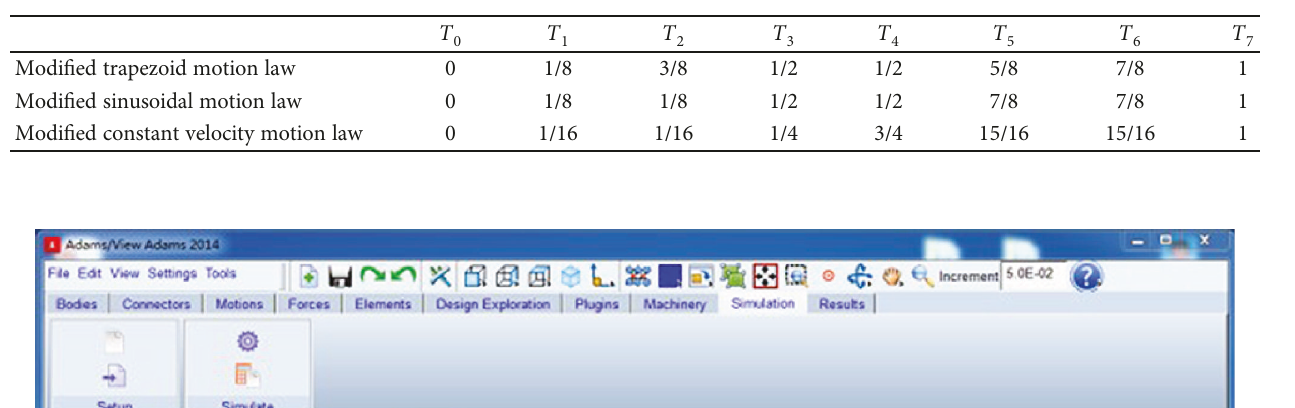
Table 2: Di ff erent motion laws.